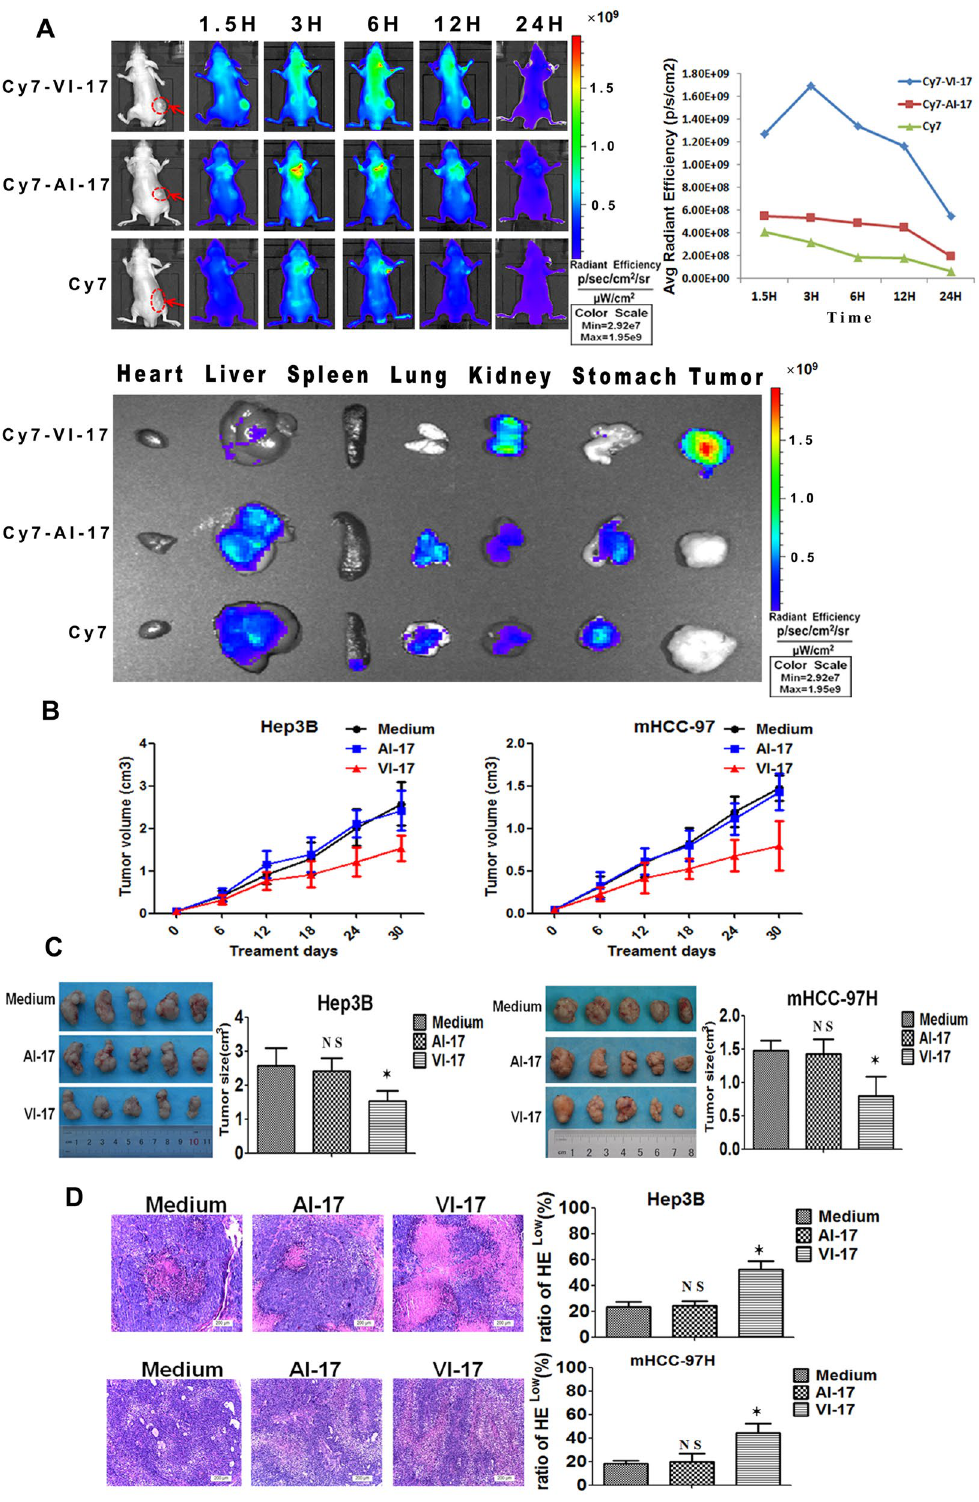
Figure 4. VI-17 was significantly accumulated in hepatoma tumor and exhibited anti-tumor activity in vivo and in vitro. (A) NIR-II fluorescence for tumor-bearing nude mice at indicating time points (left) and analysis of average radiant efficiency (right), NIR-II fluorescence for isolated tumor and organs (including heart, liver, spleen, lung, kidney and stomach). (B) Tumor volume evolution in tumor-bearing nude mice during the treatment period. (C) Analysis of tumor size in VI-17 treated tumor-bearing nude mice at 30 days. (D) HE staining for hemorrhagic necrosis area of C . Data are expressed as Mean ± SD from each group. *p <